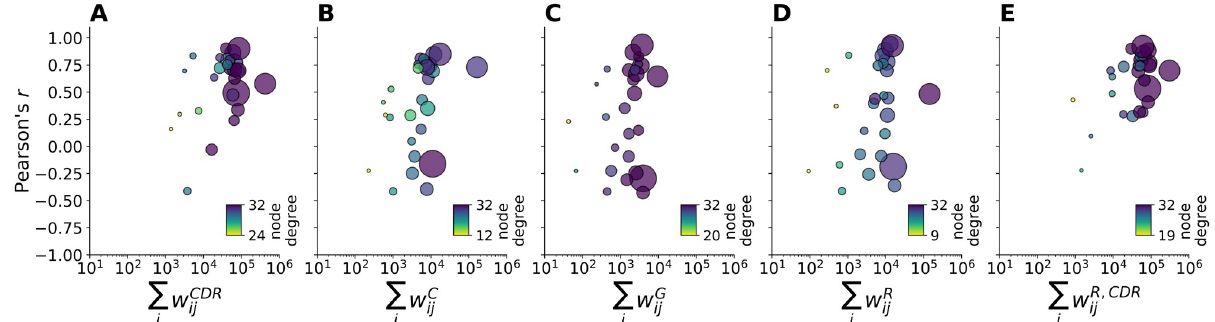
Fig 7. Correlation by main properties of mobility networks. The plots show the Pearson’s r correlation (y-axis) by the total outflows ∑ CDR-informed network ( A ), census network ( B ), gravity network ( C ), radiation network ( D ), and hybrid radiation network. Point size corresponds to population size. Colour code corresponds to node degree. Note that the scale of the colorbar changes across subplots in order to highlight the variability across networks.